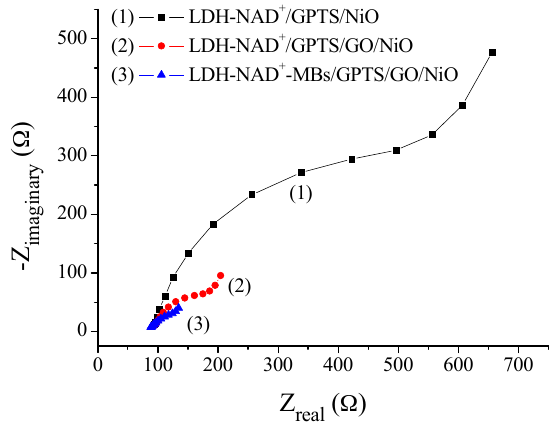
Figure 7. The Nyquist diagrams of flexible arrayed lactate biosensors based on (1) LDH-NAD + /GPTS/NiO, (2) LDH-NAD + /GPTS/GO/NiO and (3) LDH-NAD + -MBs/GPTS/GO/NiO films immersed in 0.5 mM potassium hexacyanoferrate films immersed in 0.5 mM potassium hexacyanoferrate solution.